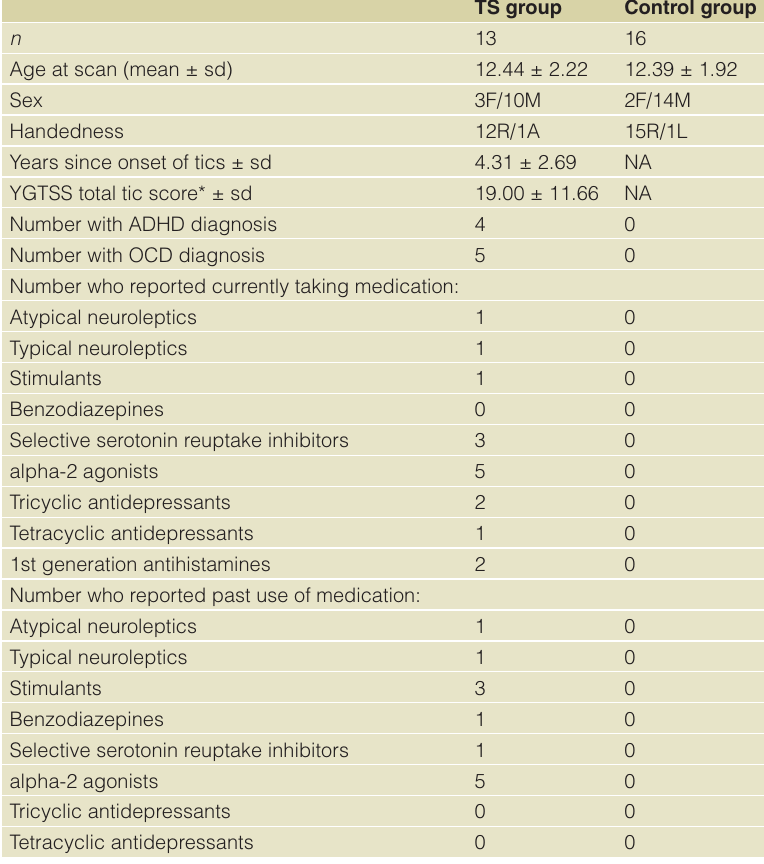
Table 1. Subject